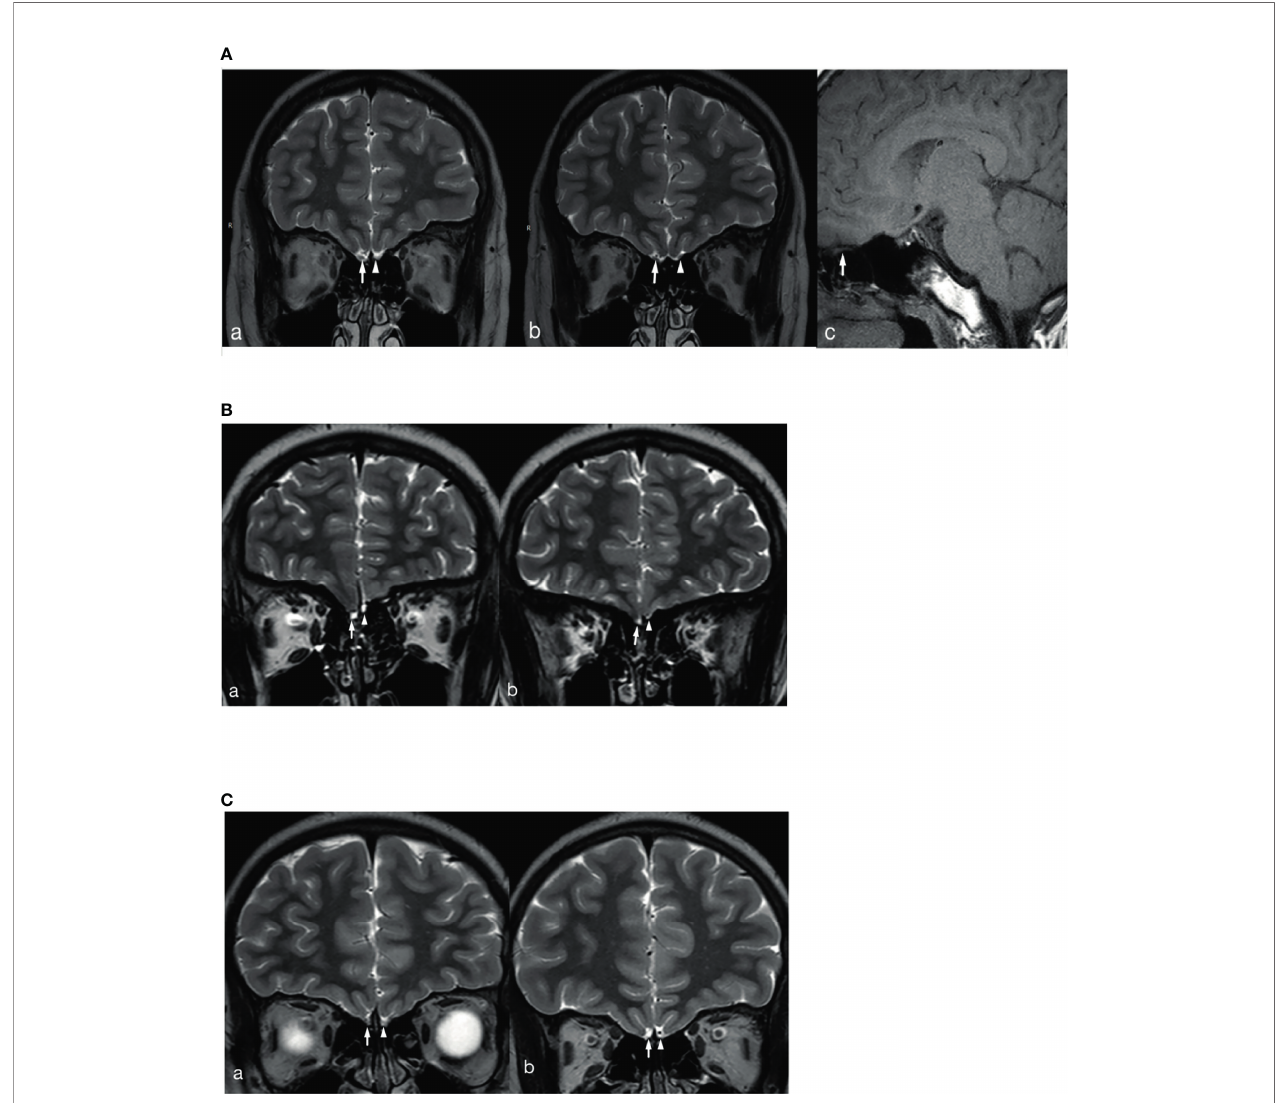
FIGURE 2 | MRI images of 3 patients with KS. (A) The right olfactory bulb and olfactory tract of the patient are normally displayed (White long arrows in a and b show the right olfactory bulb and olfactory tract, white long arrow c shows sagittal position of right olfactory tract), the left olfactory bulb is not displayed (White short arrow in a), and the left olfactory tract (White short arrow in b) is smaller than the opposite side. (B) The bilateral olfactory bulbs and olfactory tracts of the patient are not clearly displayed (White long arrows in a and b show the right olfactory bulb and olfactory tract, white short arrows in a and b show the left olfactory bulb and olfactory tract), and the left olfactory sulcus is shallower than the opposite side (a and b). (C) The bilateral olfactory bulbs and olfactory tracts of the patient are not clearly displayed (White long arrows in a and b show the right olfactory bulb and olfactory tract, white short arrows in a and b show the left olfactory bulb and olfactory tract), and the bilateral olfactory sulcus is shallow (a and